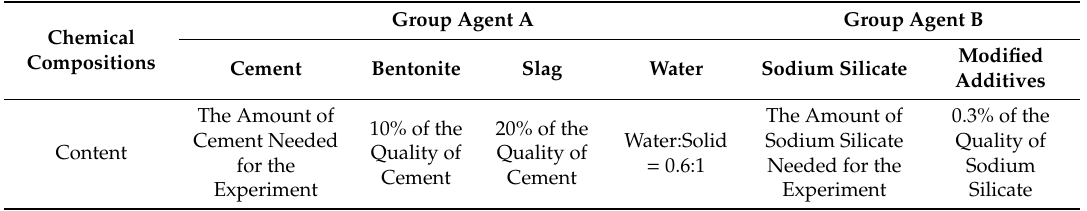
Table 2. The chemical compositions of the HGTGS.